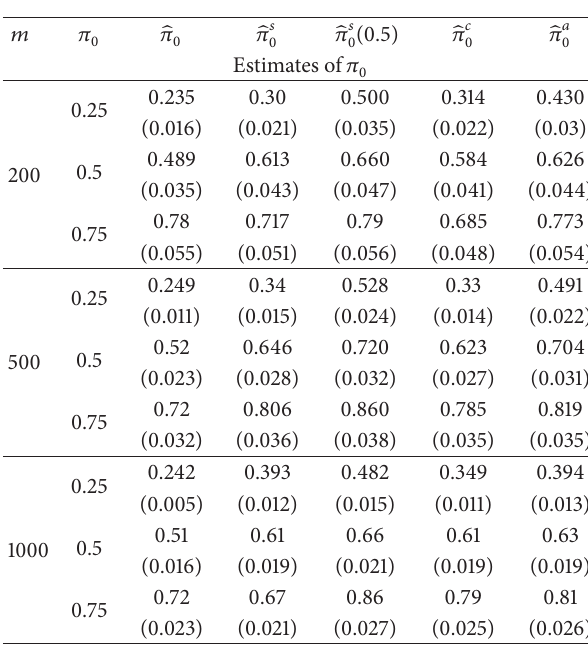
Table 2: Monte Carlo empirical estimates with standard deviations (in parentheses) by the new innovative approach along with existing estimators. The Monte Carlo size is 1,000 in each case. Denote ̂𝜋 0 for the new estimator, ̂𝜋 𝑠 0 for Storey’s estimator, ̂𝜋 𝑠 0 (0.5) for Storey’s estimator with 𝜆 = 0.5 , ̂𝜋 𝑐 0 for the convex method estimator, and ̂𝜋 𝑎 0 for the average method estimator.